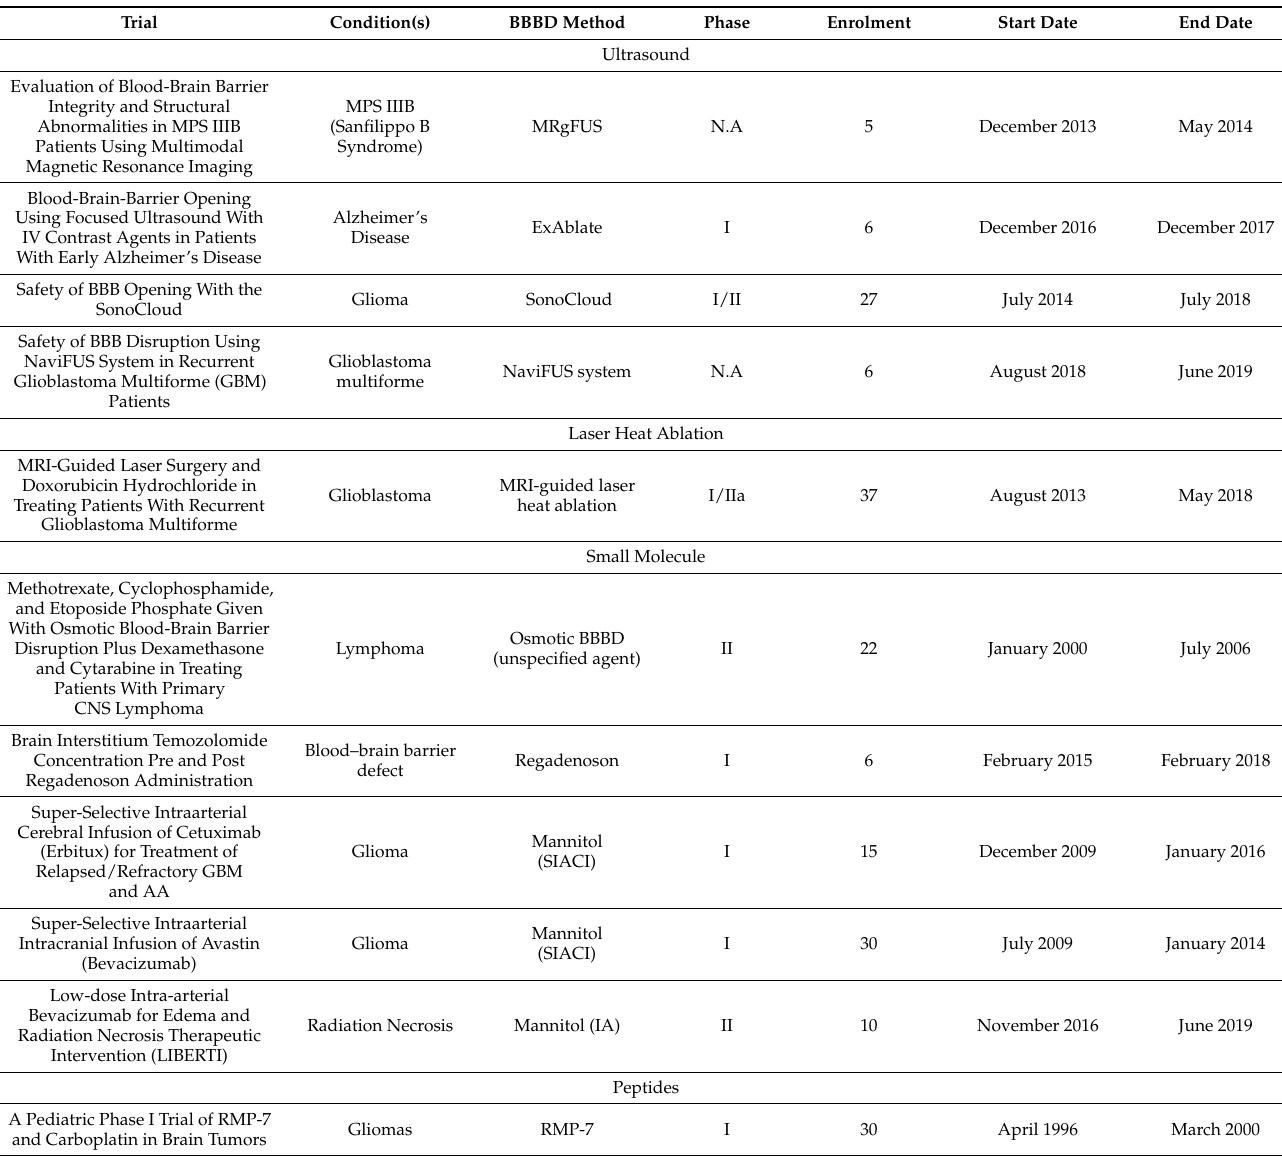
Table 6. Completed NIH Clinical Trials in Therapeutic blood–Brain Barrier Disruption